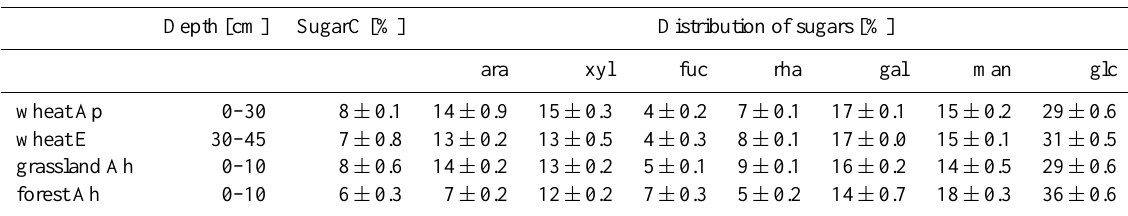
Table 1. Sugar composition of the organic matter in the wheat Ap, wheat E, grassland Ah and forest Ah soils before incubation. Means ± standard error, n = 3.